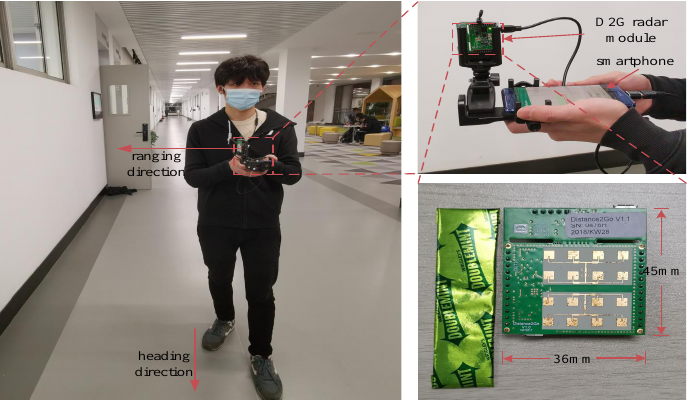
Figure 1. The FMCW radar and experiment